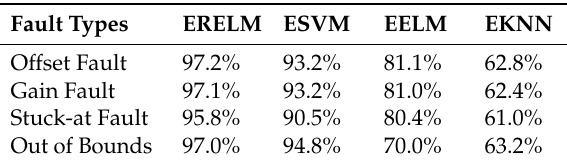
Table 6. DA with 40% induced faults.